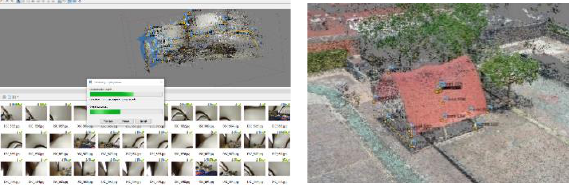
Figure 13. Left: Photo aligning process in Aigsoft Photoscan Software using the target points. Right : Dense cloud of the whole site created in Agisoft Photoscan Software (Produced by Rajabzadeh, 2019)